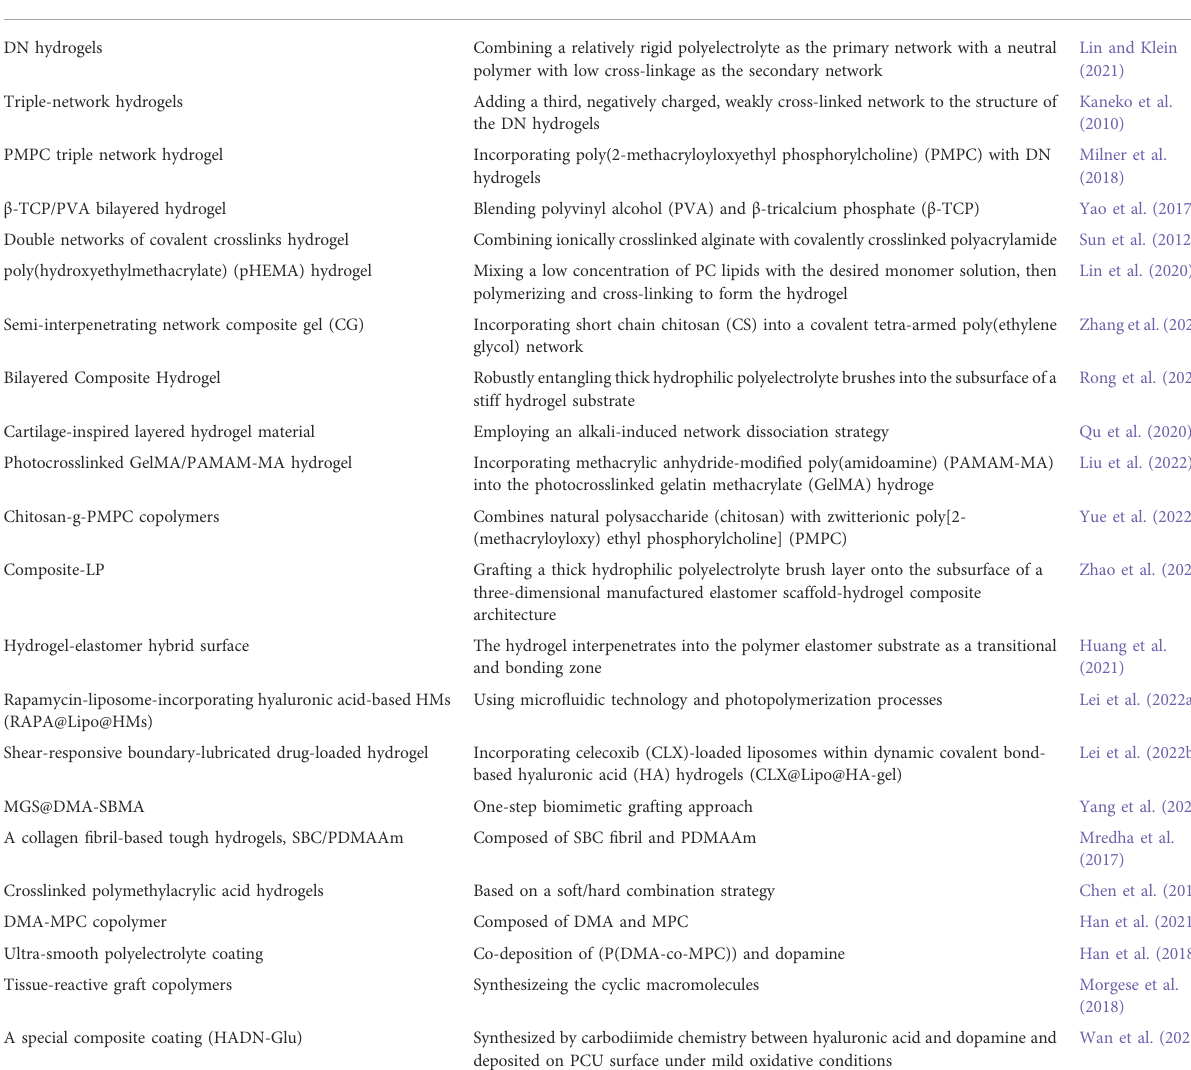
TABLE 1 Typical bio-inspired cartilage lubrication